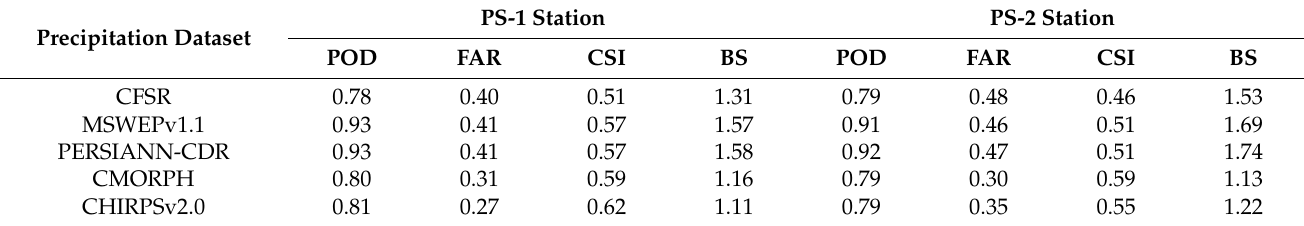
Table 6. Precipitation detection metrics based on comparison with gauge observation at PS-1 station and at PS-2